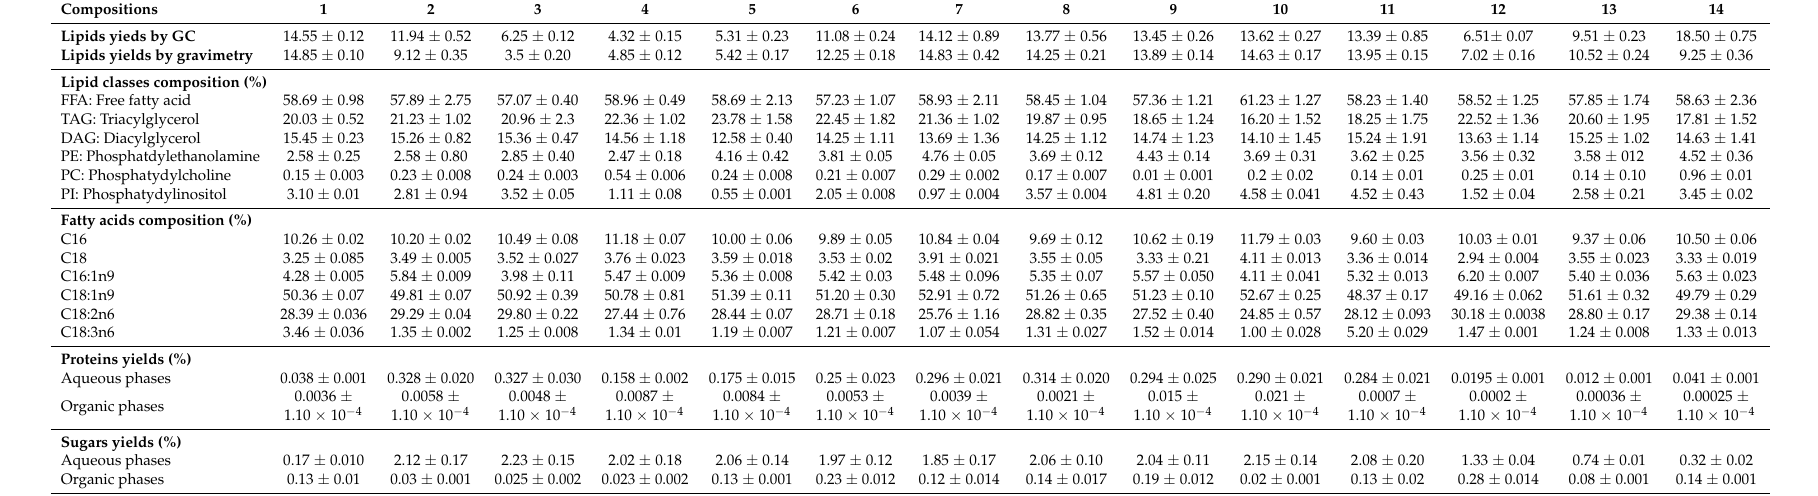
Table 2. Crude lipids, distribution of lipid classes, fatty acids, proteins and glucose compositions of extracts (organic and aqueous phases) obtained by extractions with different ratios of classical solvents. Lipid yields and gravimetric yields (g per 100 g of dry matter), lipid classes and fatty acids compositions (relative percentages). Proteins and sugars yields in g per 100 g of dry